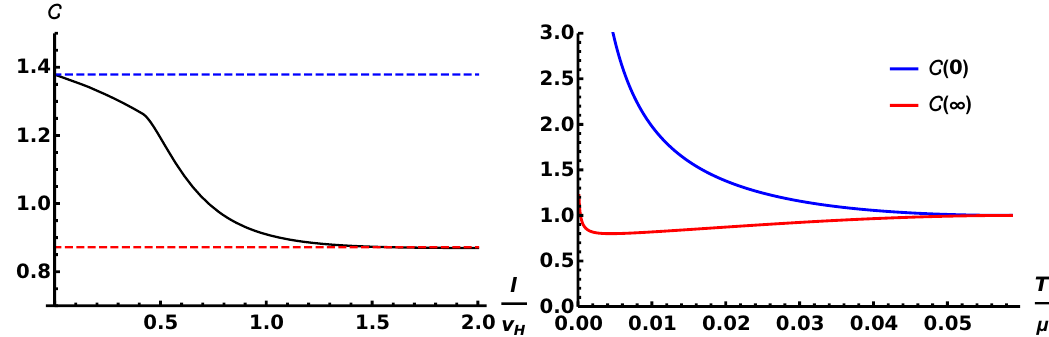
Figure 8 . Left : we depict the candidate c -function as defined in (4.12) for fixed T/µ = 0 . 02 . As expected, it will faithfully count the number of coherent charged degrees of freedom and will therefore only decrease in the scales when the minimal surfaces dive through the cloud region in the bulk. The blue/red dashed lines denote the UV/IR-limits of the proposed c -function which can be computed analytically. The slight knee visible in the curve around l/v 0 . 4 corresponds H ≈ to the point where the minimal surfaces start probing the cloud. Right : we depict the effective number of degrees of freedom at the UV C = C (0) and at the IR C = C ( ∞ ) as a function of UV IR T/µ . Interestingly, C UV can be shown to be proportional to the ratio between the total charge and the black hole charge (4.14), so it can be used as a probe to diagnose and quantify the existence of cohesive charges in the